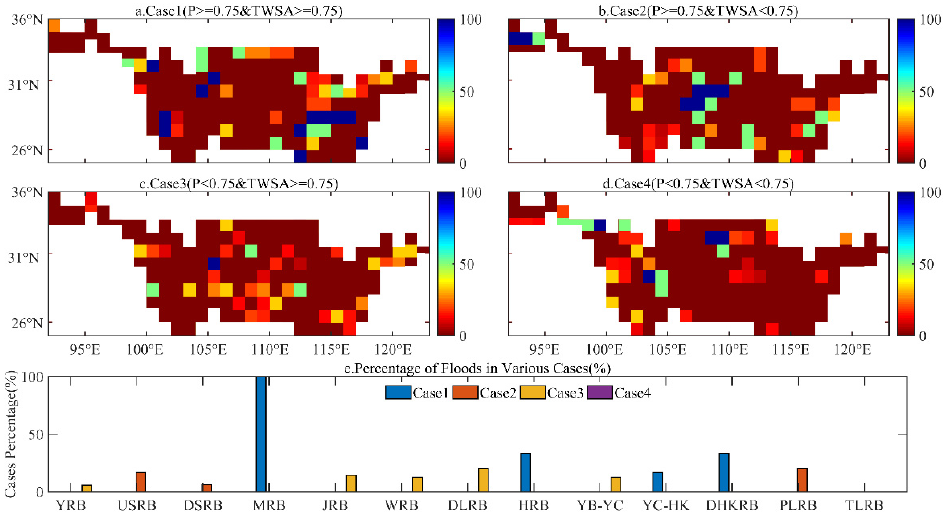
Figure 6. Percentage of extreme runoff (i.e., runoff ≥ 75%) falling in these four kinds of Case for the combination between precipitation and TWSA in the YRB and its sub-basins during April 2002–December 2019.